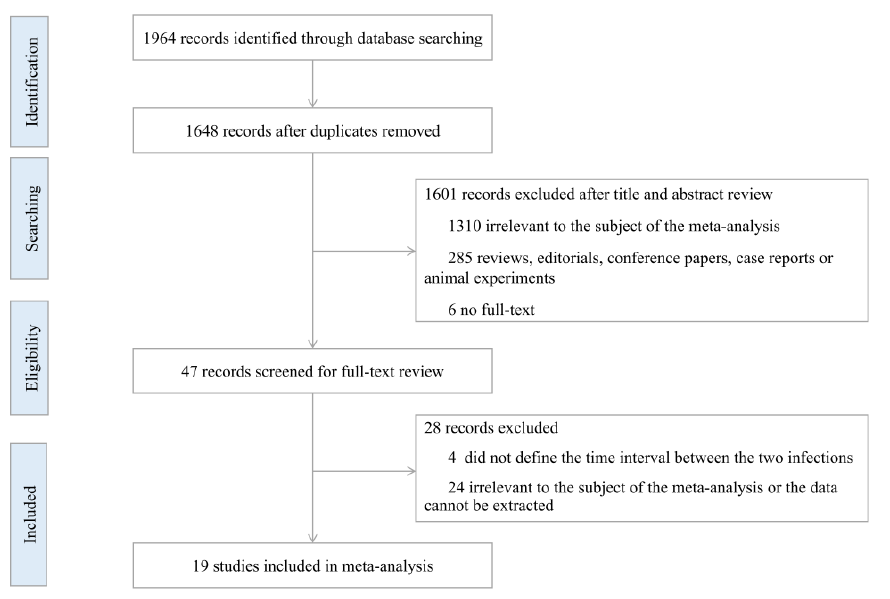
Figure 1. Flowchart for study selection.